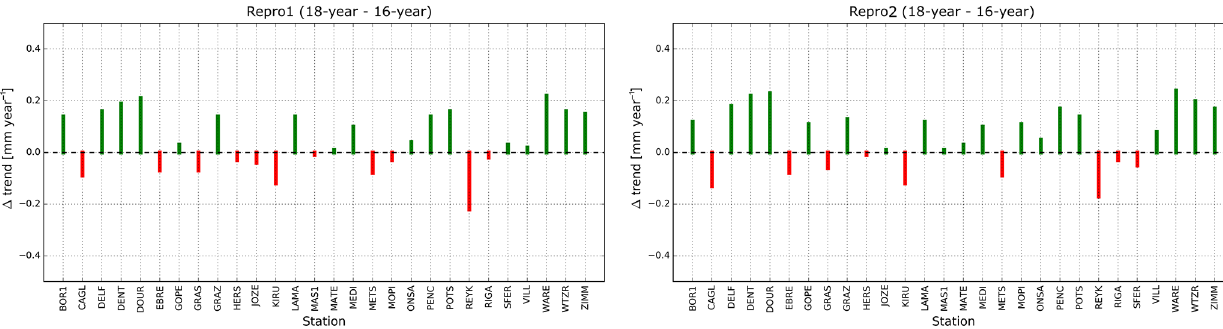
Figure 9. Differences in trend values for the 18-year and the 16-year time series obtained from the Repro1 (left) and Repro2 (right)